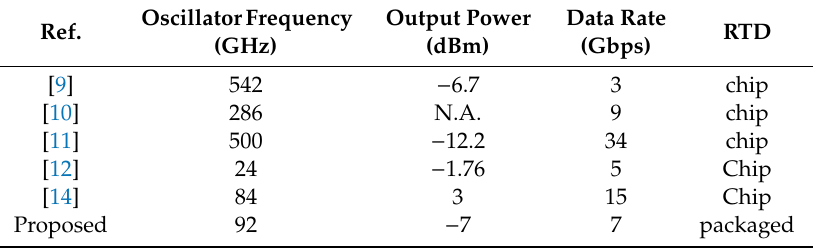
Table 2. Performance of the proposed